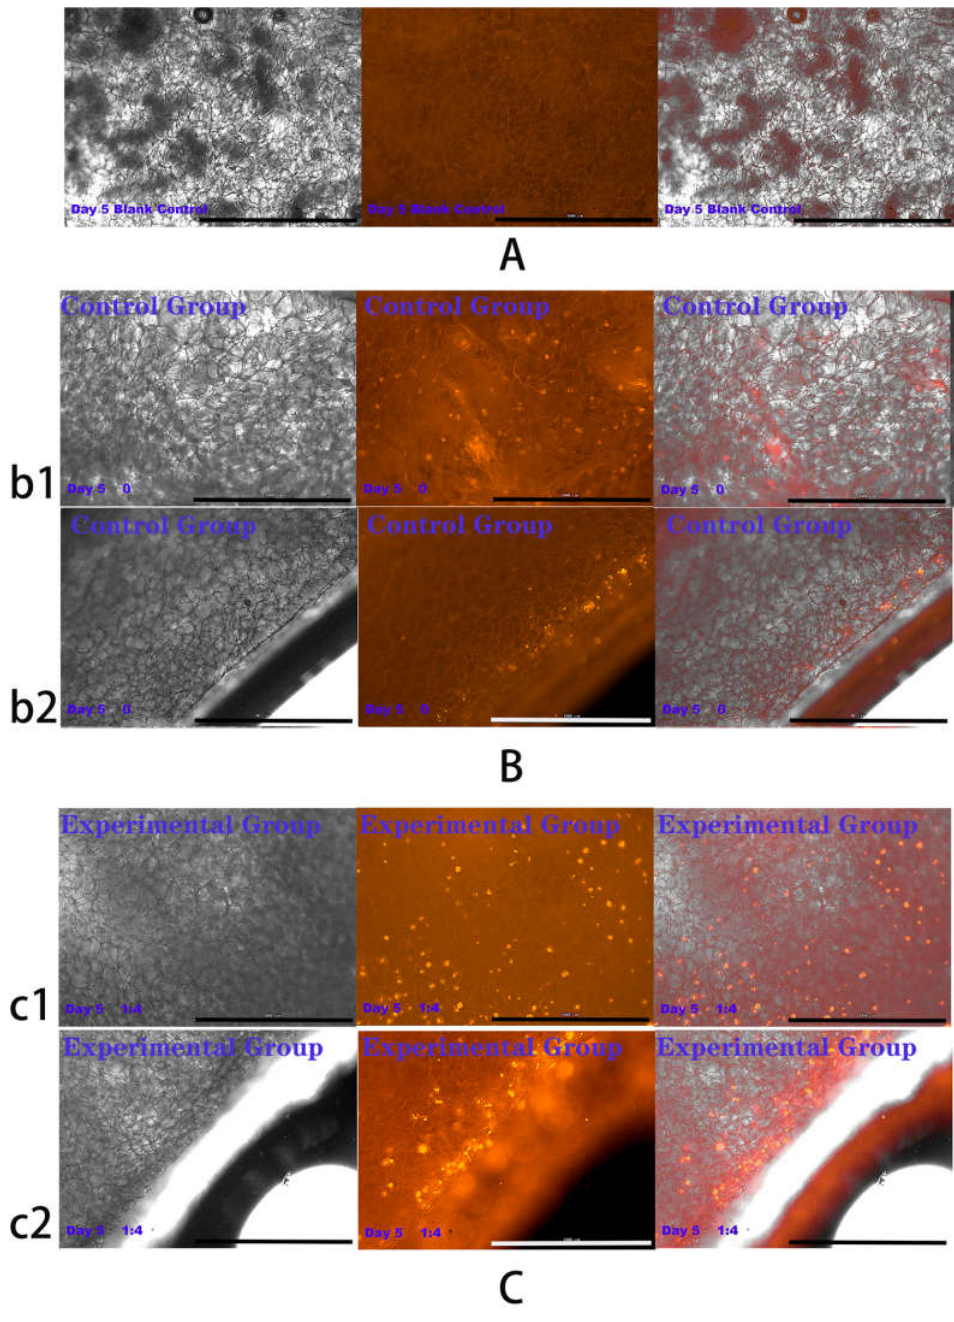
Figure 14. Cells were co-cultured for 5 days. Growth of HSFs labeled with amino graphene quantum dots on tissue engineering scaffolds. b1 and c1 and are fluorescence maps of HSFs growing on the surface of tissue engineering scaffolds. b2 and c2 are fluorescence maps of HSFs growing on the cross section of the tissue engineering scaffolds. ( A ) Blank group, ( B ) control group, ( C ) is experimental group. From left to right are the bright field diagram, the fluorescent field diagram, and the sum diagram of the bright field and the fluorescent field. Scale bar: 1000 μm.